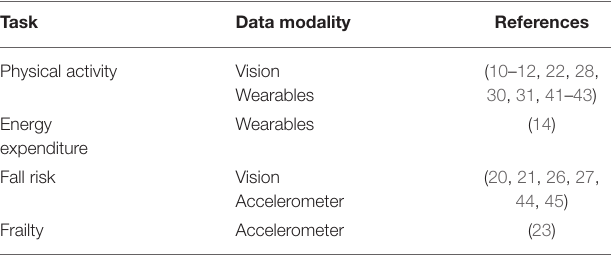
TABLE 1 | Peer-reviewed publications using wearable devices and computer vision in monitoring